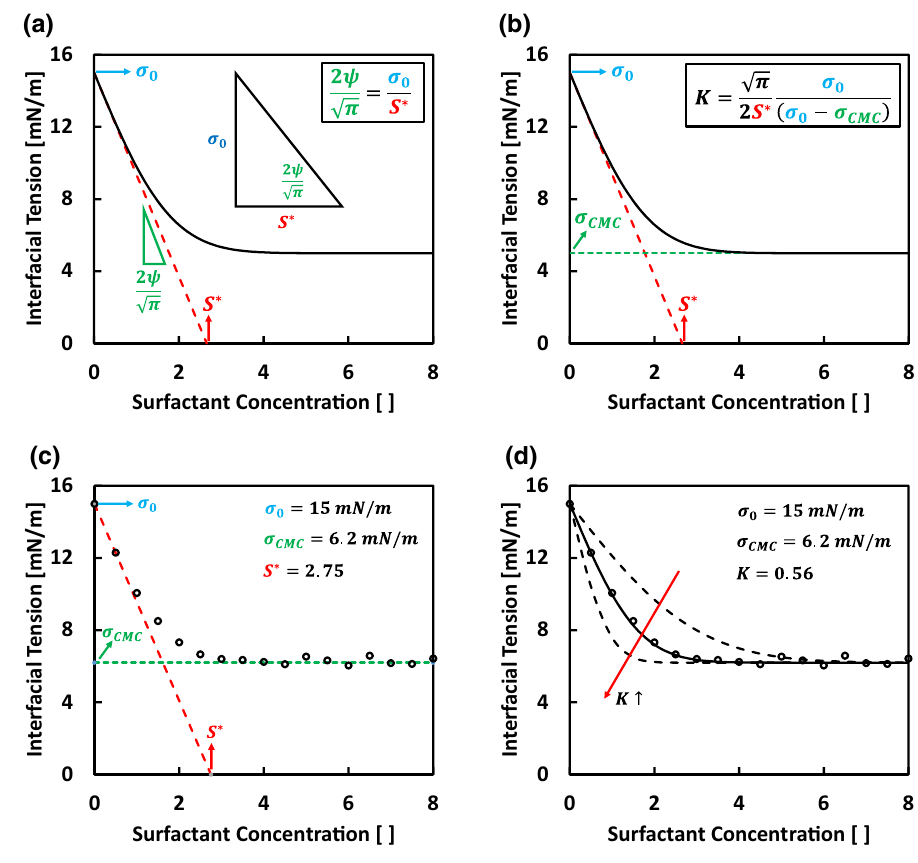
Fig. 2 Surfactant